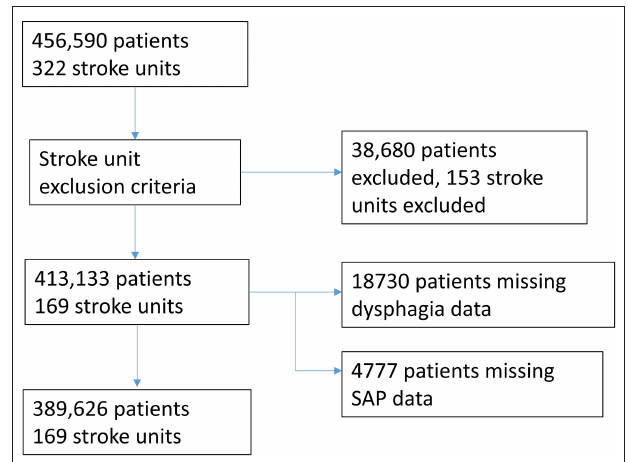
FIGURE 1 | Flow diagram showing exclusion criteria and missing data to arrival at final sample